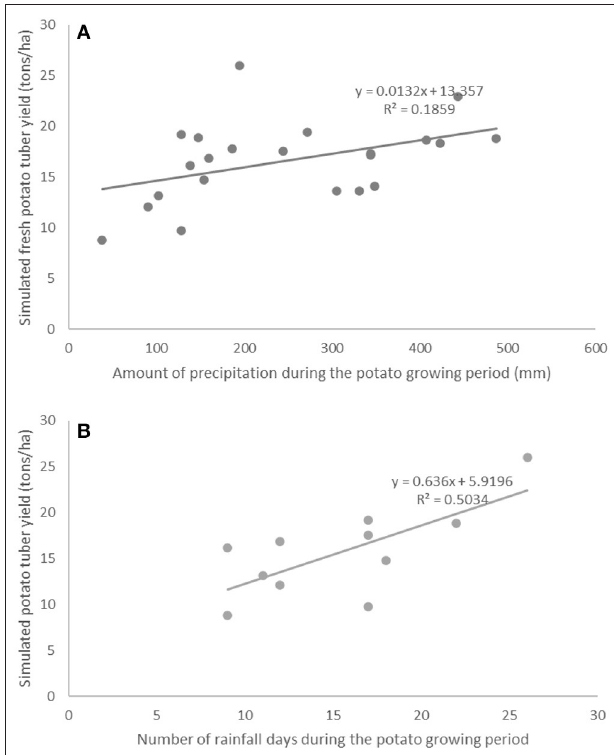
FIGURE 6 | Simulated potato tuber yield in response to total rainfall (A) and number of rainfall days (B) during the Belg season at Barneb 2 irrigation scheme in Northeastern Ethiopia. Simulations were made based on daily climate data of 20 years (2001–2020).